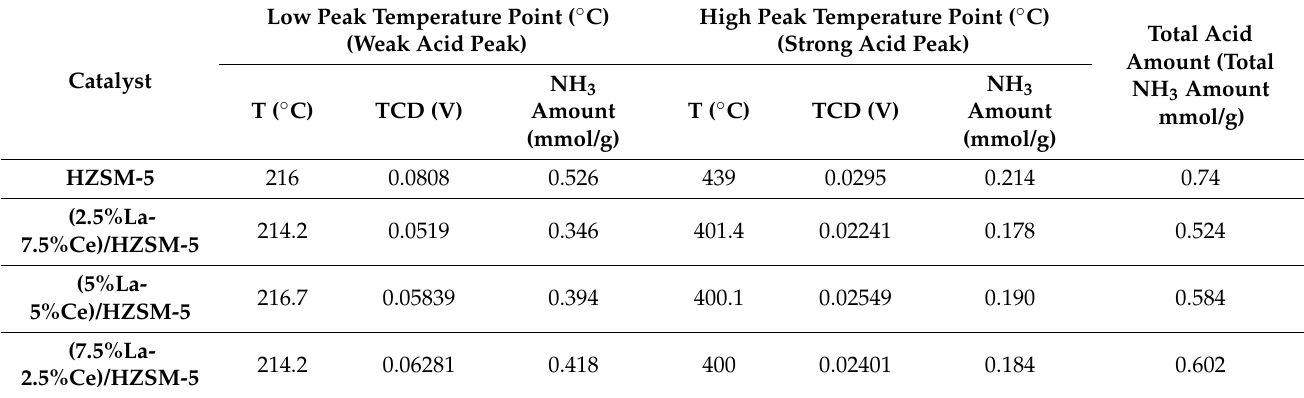
Table 3. NH 3 -TPD properties of HZSM-5, (2.5%La-7.5%Ce)/HZSM-5, (5%La-5%Ce)/HZSM-5, and